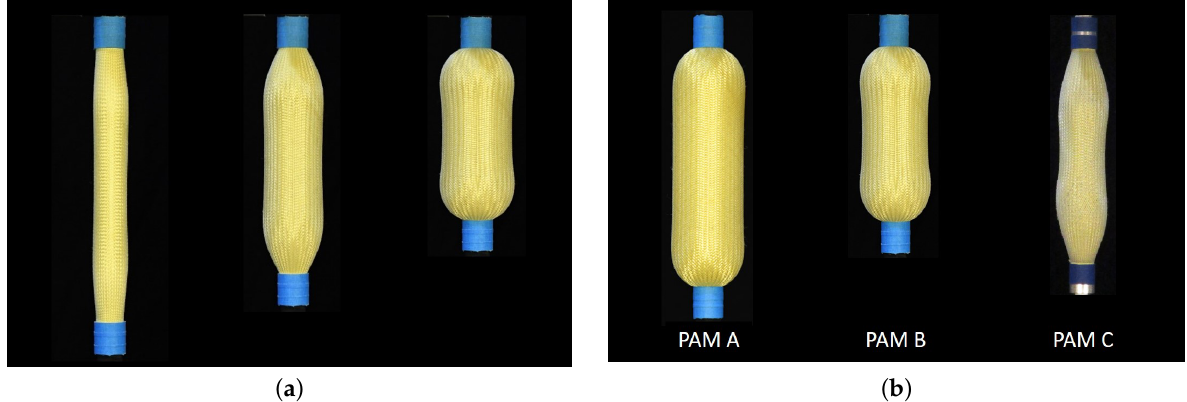
Figure 2. Variation of the PAM’s shape profile for: ( a ) A single PAM in different states of contraction. ( b ) Three different PAMs (same construction) in their free-contraction states